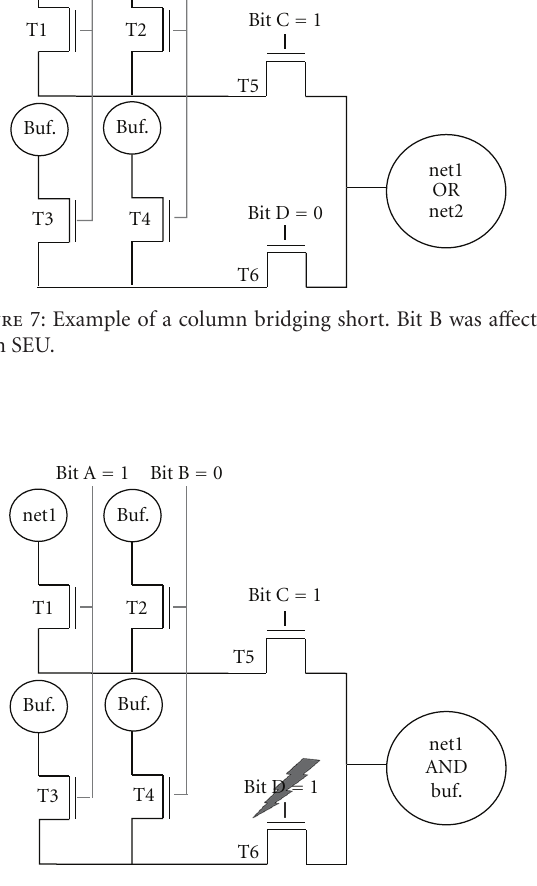
Figure 8: Example of a row bu ff er short. Bit D was a ff ected by an SEU.